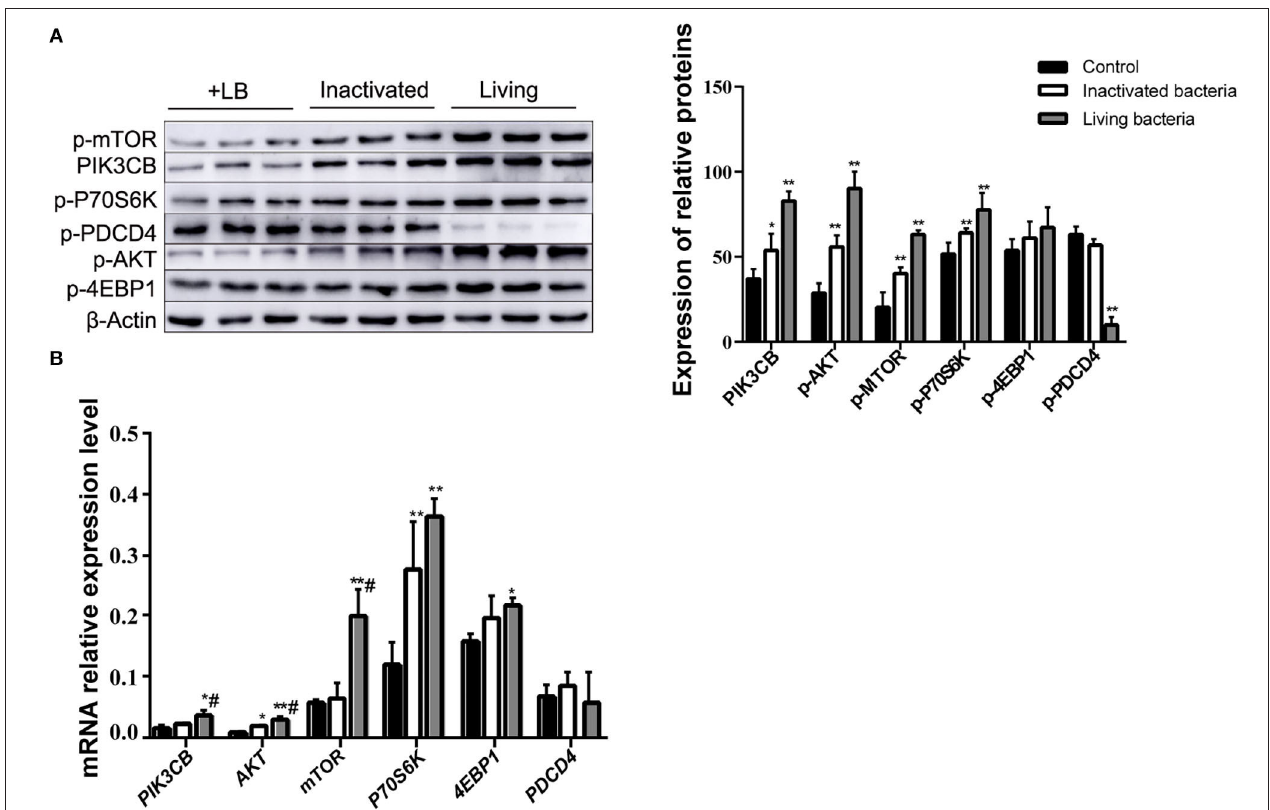
FIGURE 8 | Expression of proteins (A) and genes (B) in the rumen explants with living and inactivated bacteria ( n = 9). One-way ANOVA in SPSS 22.0 software was used to analyse the data, presented as mean ± sd. The ratio of all gene expression levels compared to the housekeeping gene β -actin was obtained as the relative expression of the gene. *Indicates significant difference from control group within the same group ( p < 0.05). # Indicates significant difference compared to other groups at the same time or the same concentration gradient ( p < 0.05). **Indicates a highly significant difference ( p <